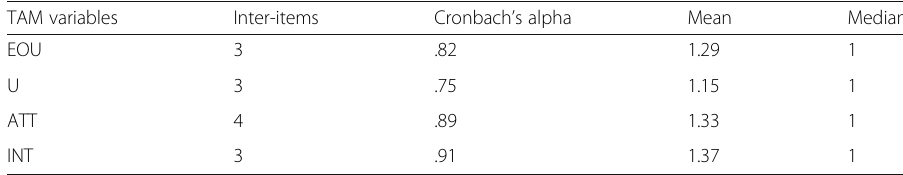
Table 5 Technology acceptance